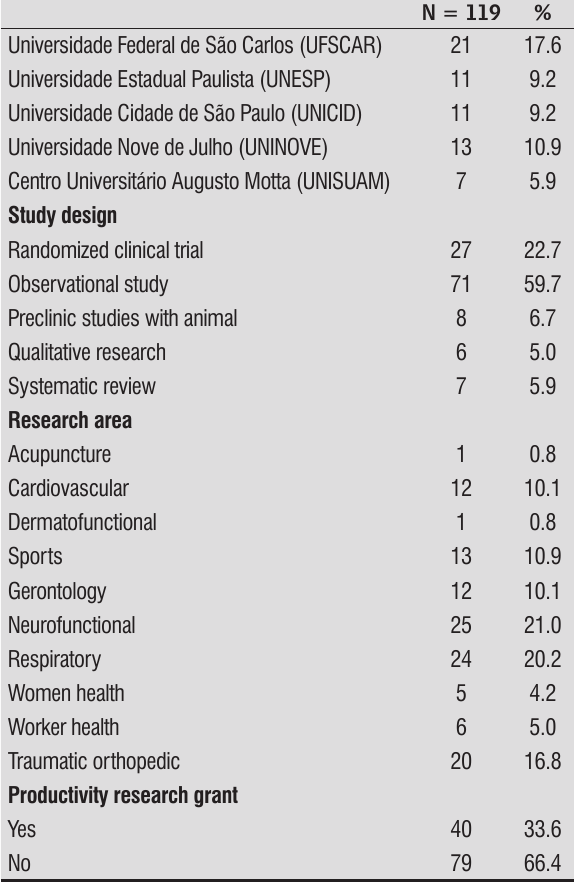
Table 1 - Characteristics of the researchers of the doctoral programs in physiotherapy, Brazil, March